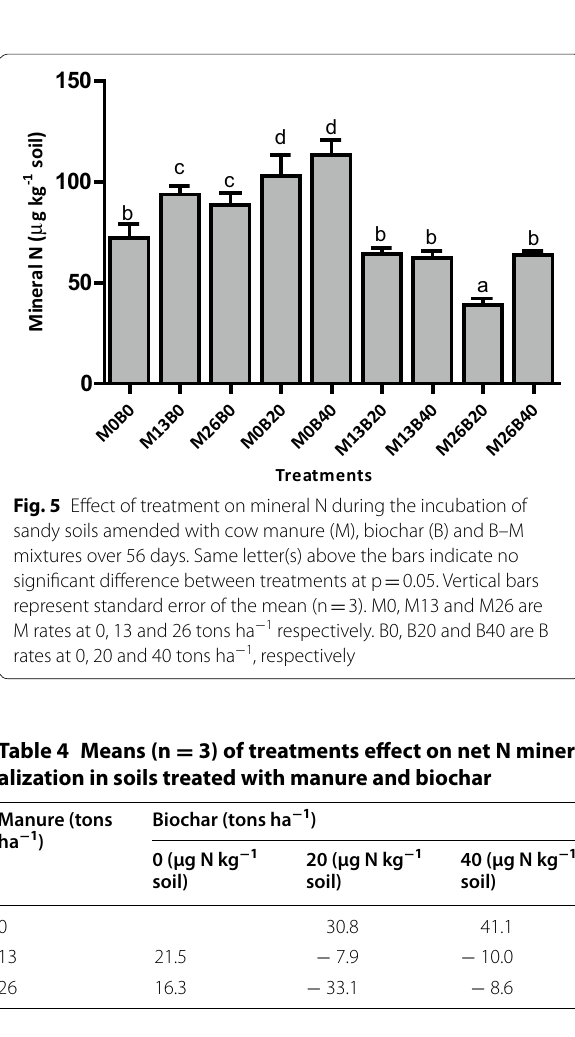
Table 4 Means (n 3) of treatments effect on net N miner- = alization in soils treated with manure and biochar Manure (tons ha − 1